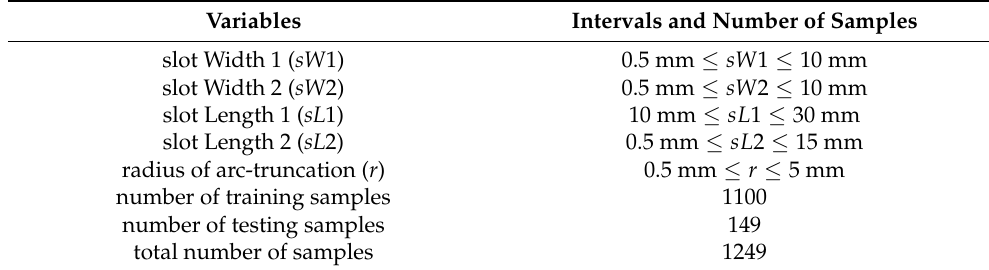
Table 1. Sampling procedure for training and testing.